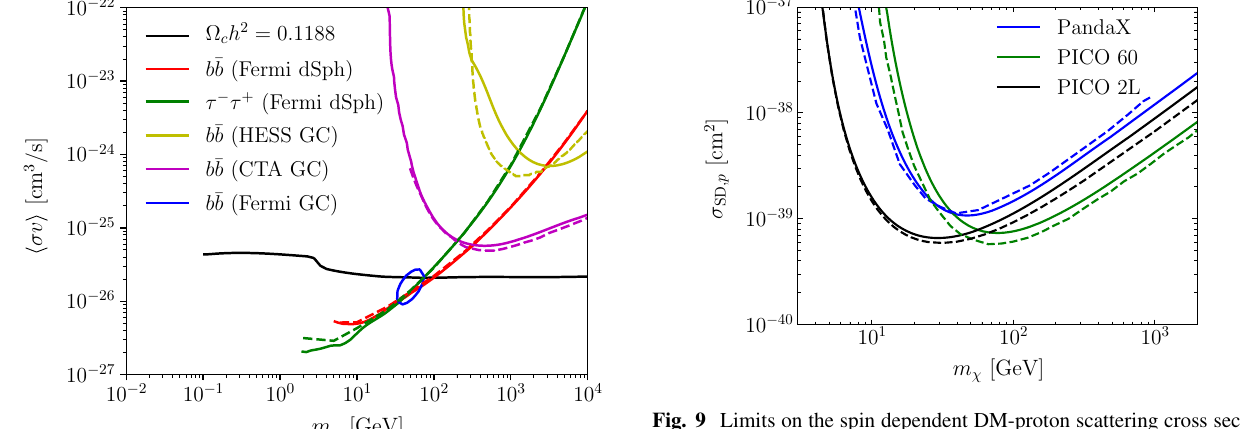
Fig. 9 Limits on the spin dependent DM-proton scattering cross sec- tion from PICO-2L, PICO-60L, and PandaX at 90% CL. The solid curves are the limits determined using DarkBit and the dashed curve are the official limits from the collaborations